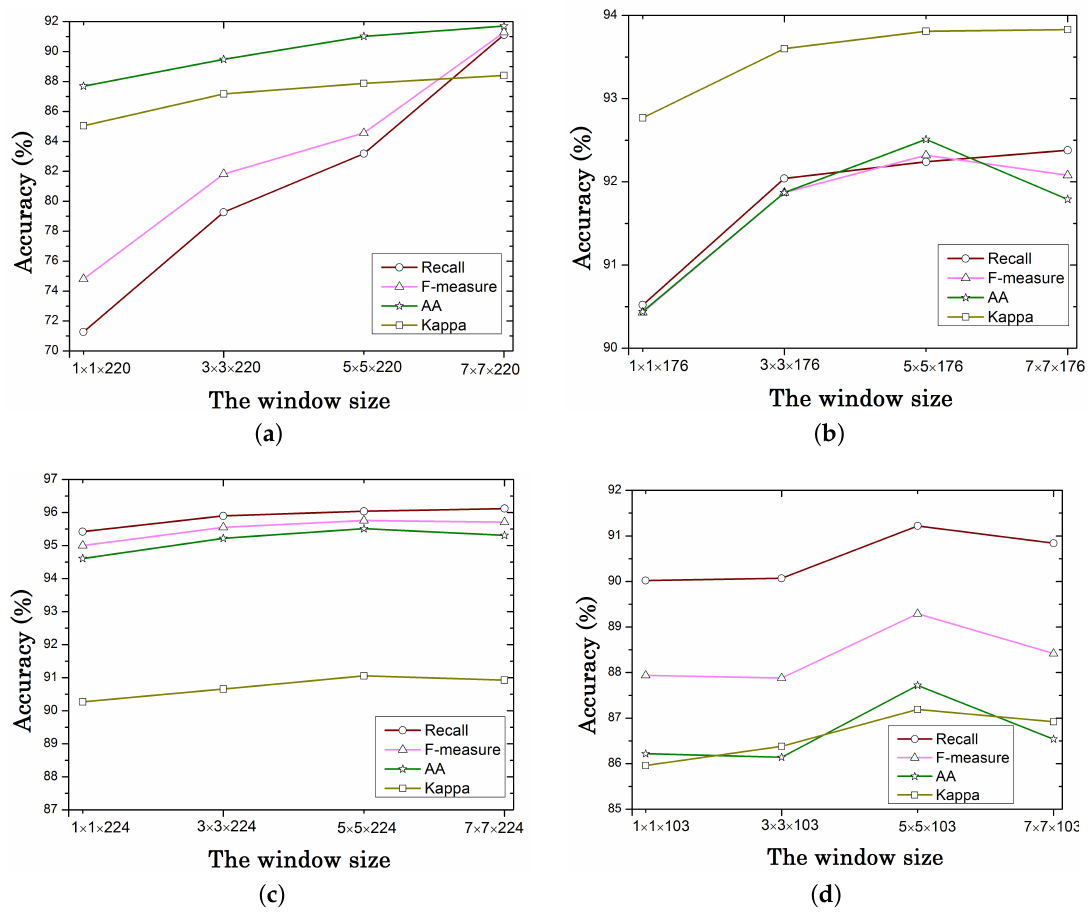
Figure 8. Recall, AA, F-measure and Kappa of SMOTE-WDRoF with different window sizes on four hyperspectral image datasets. ( a ) Indian Pines AVRIS , ( b ) KSC , ( c ) Salinas and ( d ) the University of Pavia ROSIS